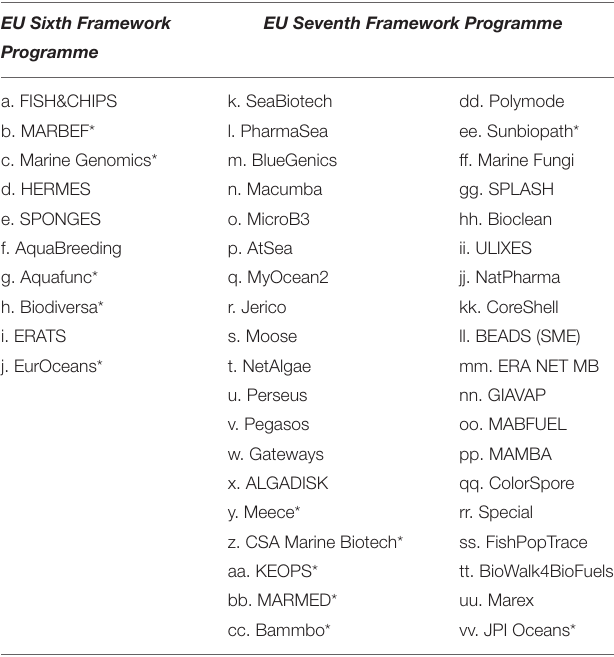
TABLE 1 | European framework programs related to marine